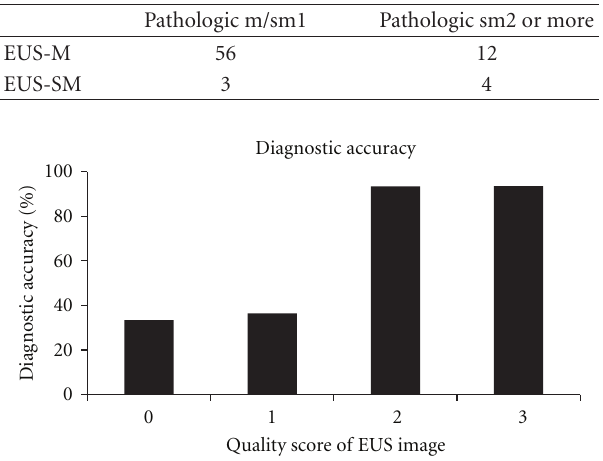
Figure 2: Association between the quality of EUS images and diagnostic